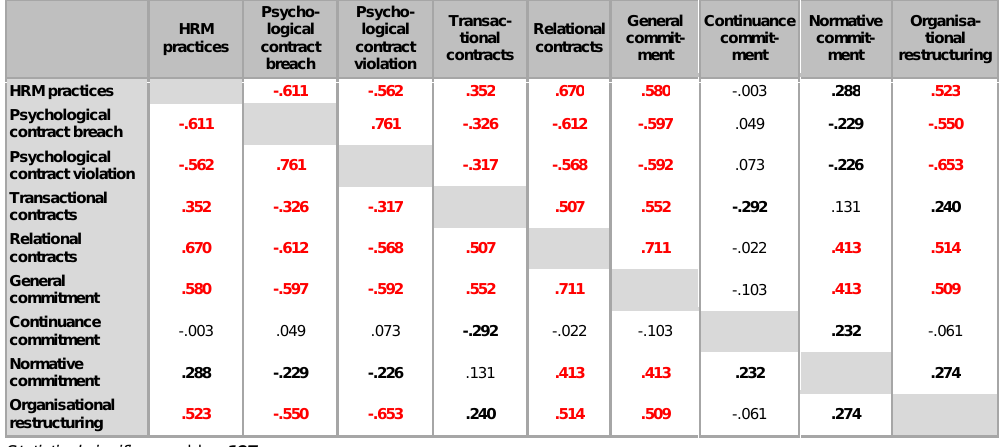
Pearson product moment correlation coefficients for the summated